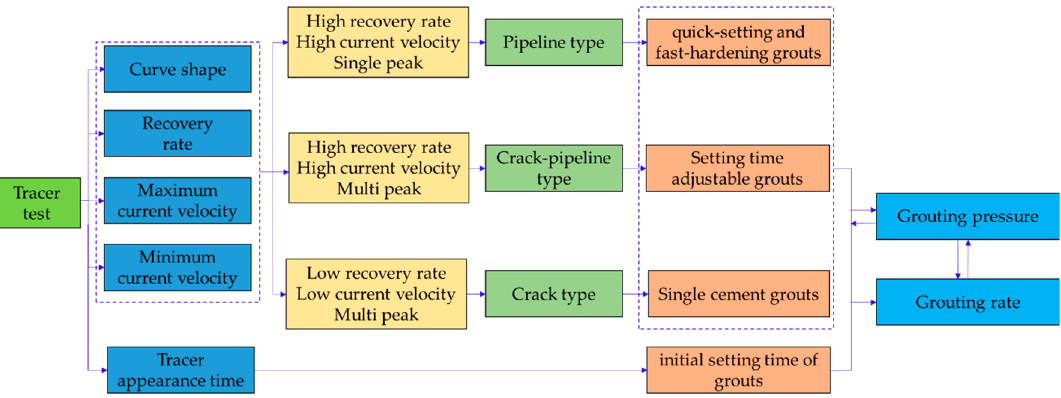
Figure 4. The technology roadmap of targeted grouting.